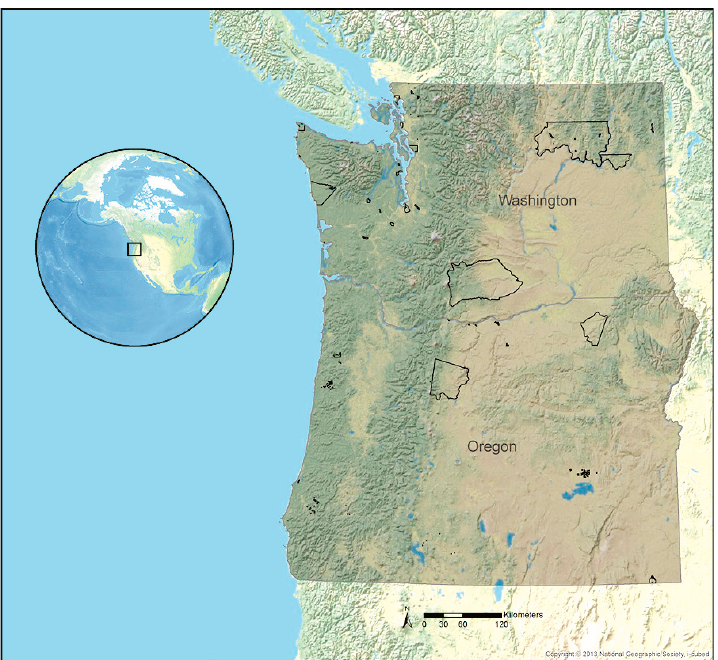
Figure 1. Study area showing the gray shaded extent of our analysis encompassing Oregon and Washington (U.S.) and tribal reservations delineated in black